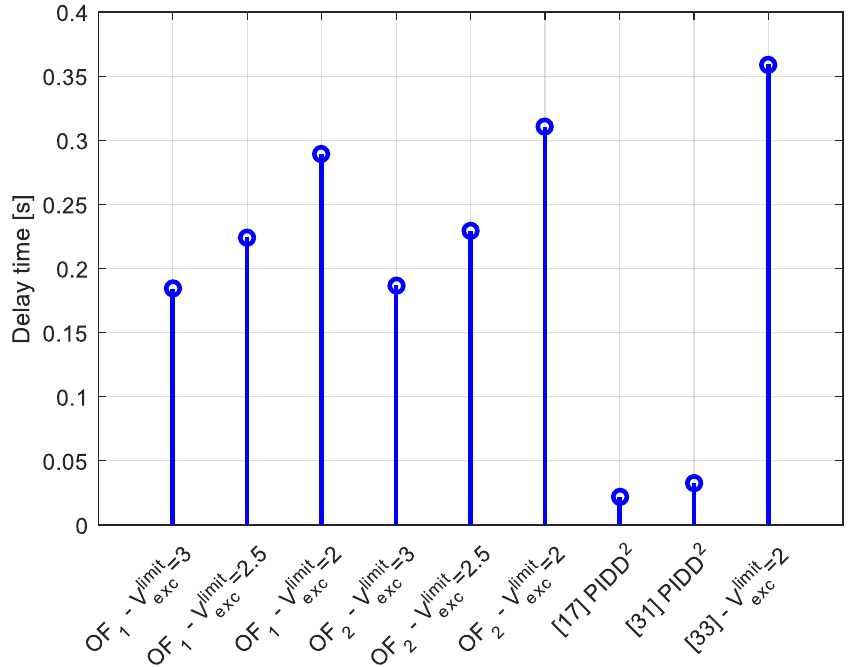
Figure 12. Comparison of the results in terms of the delay time obtained using different methods.